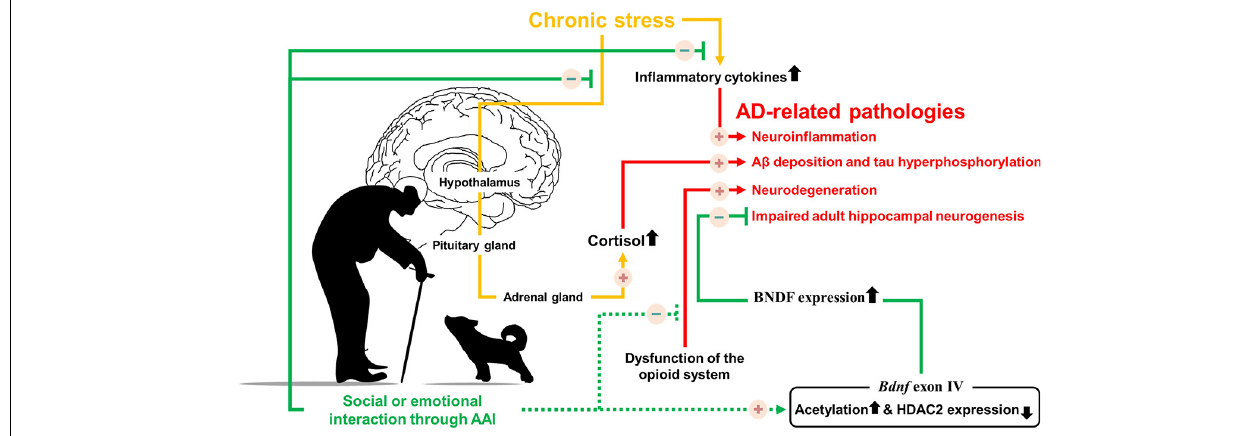
FIGURE 1 | Possible neurological mechanism involved in Alzheimer’s disease symptoms alleviation by providing emotional or social interaction through animal assisted intervention. Solid line indicates the known mechanisms, dotted line indicates hypothesized mechanisms.